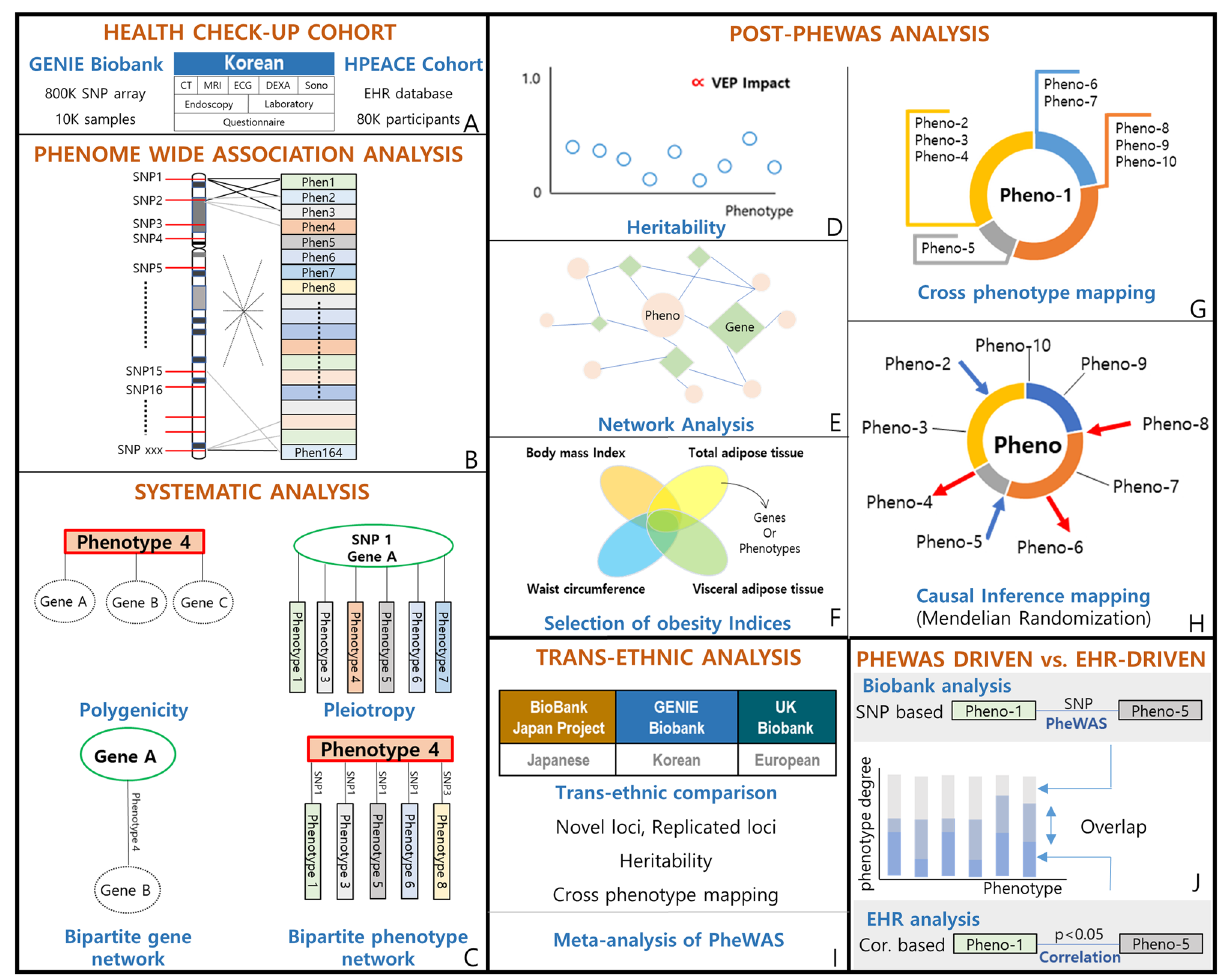
Figure 1. Overview of the study design. ( A ) We utilized a health check-up cohort on comprehensive health check-up. Sub-cohorts of this cohort are the Gene-EnvironmeNtal IntEraction and phenotype (GENIE) cohort, which includes biobank data, and the Health and Prevention EnhAnCEment (H-PEACE) cohort, which includes an EHR database of the health check-up results. ( B ) Phenome wide association study (PheWAS) was performed for 136 phenotypes adjusting for age, sex, and PC1-PC3. ( C ) We leveraged cross-phenotype associations to perform systematic analysis of the PheWAS results, which were polygenicity, pleiotropy, a bipartite gene network, and a bipartite phenotype network. The details are described in Fig. 4. ( D ) To ensure robustness of the PheWAS results, we further dissected the results to suggest applicable interpretations, the heritability for each phenotype; Correlation between phenotype heritability and the effect of the loci on genes and protein sequences associated with phenotypes. ( E ) Using cross-phenotype association information, we constructed phenotype-phenotype and phenotype-genotype networks. ( F ) We visualized the comparison of obesity indices (body mass index, waist circumference, visceral adipose tissue, and total adipose tissue amount). ( G ) We constructed cross-phenotype mappings, which have a core phenotype (Pheno-1 in the figure) and branches of connected phenotypes that share loci. These were partitioned by color according to the biological system involved. ( H ) We estimated causal inferences in the phenotype pairs from cross-phenotype associations using Mendelian randomization and constructed a causal inference map. ( I ) We performed trans- ethnic and trans-nationality analysis among Korean, European, and Japanese populations. ( J ) We compared phenotype-phenotype pairs generated from SNP-based cross phenotype-association in the Biobank analysis with those generated from correlation analysis in the EHR-based H-PEACE cohort. We evaluated the overlap or exclusiveness of pairs for each phenotype by phenotype or networks, the degree property indicates the number of direct connections between one core component and other components. For each core gene/phenotype, the number of genes associated or connected with it is defined as its gene degree, and the number of phenotypes associated or connected is its phenotype degree. We used the cross-phenotype association information to construct a phenotype-phenotype network and a phenotype-genotype network in order to find hidden relationships among phenotypes or genotypes and also to identify hub genes or hub phenotypes. The Gephi software (https:// gephi. org/) was used to visualize the network 17 .